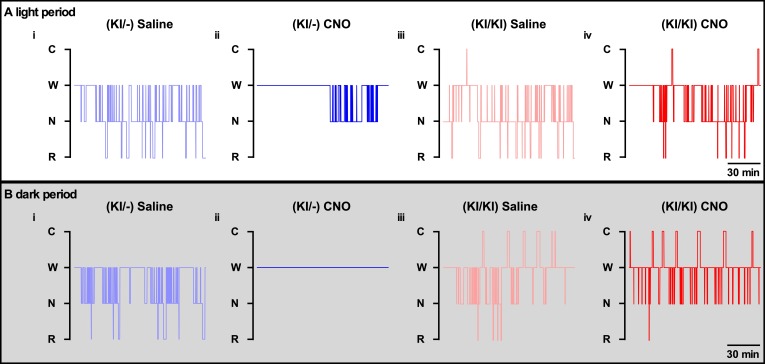
Representative hypnogram of OF mice after i.p. administration of either saline or CNO.(A and B) hypnograms showing vigilance state change for 2 hr after i.p. administration during either light (A) or dark (B) period in OF (KI/-, i and ii) or OF (KI/KI, iii and iv) mice. C: cataplexy, W: wakefulness, N: NREM sleep, R: REM sleep.